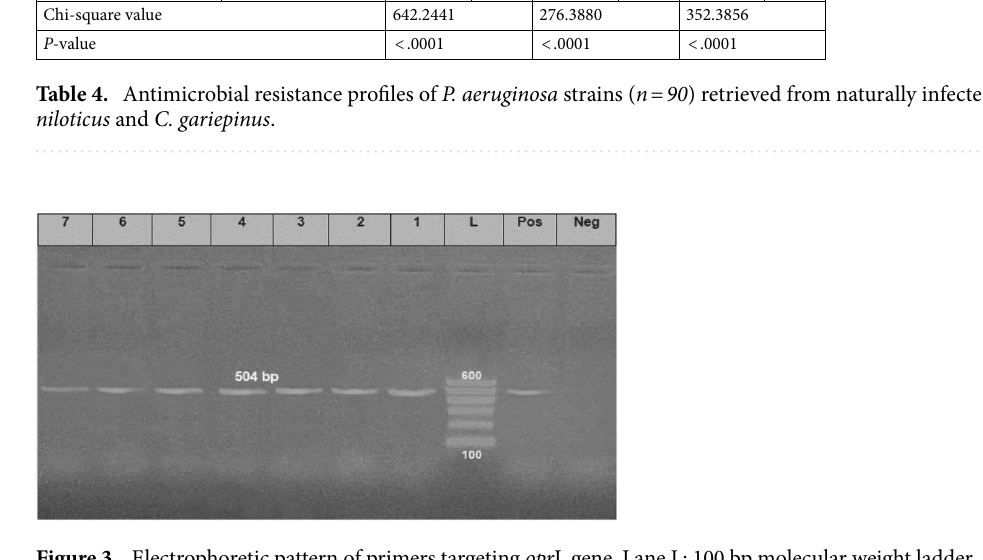
Figure 3. Electrophoretic pattern of primers targeting opr L gene. Lane L: 100 bp molecular weight ladder (Fermentas, Thermo Scientific, Germany); lane Pos: the positive control (Reference strain from Animal Health